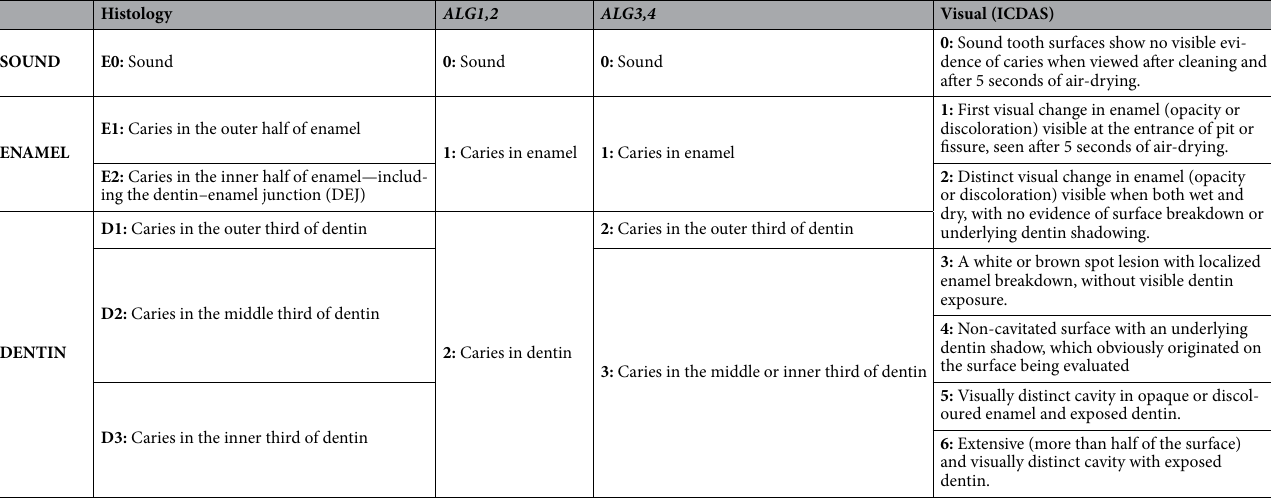
Table 1. Scoring systems employed by the different methods according to